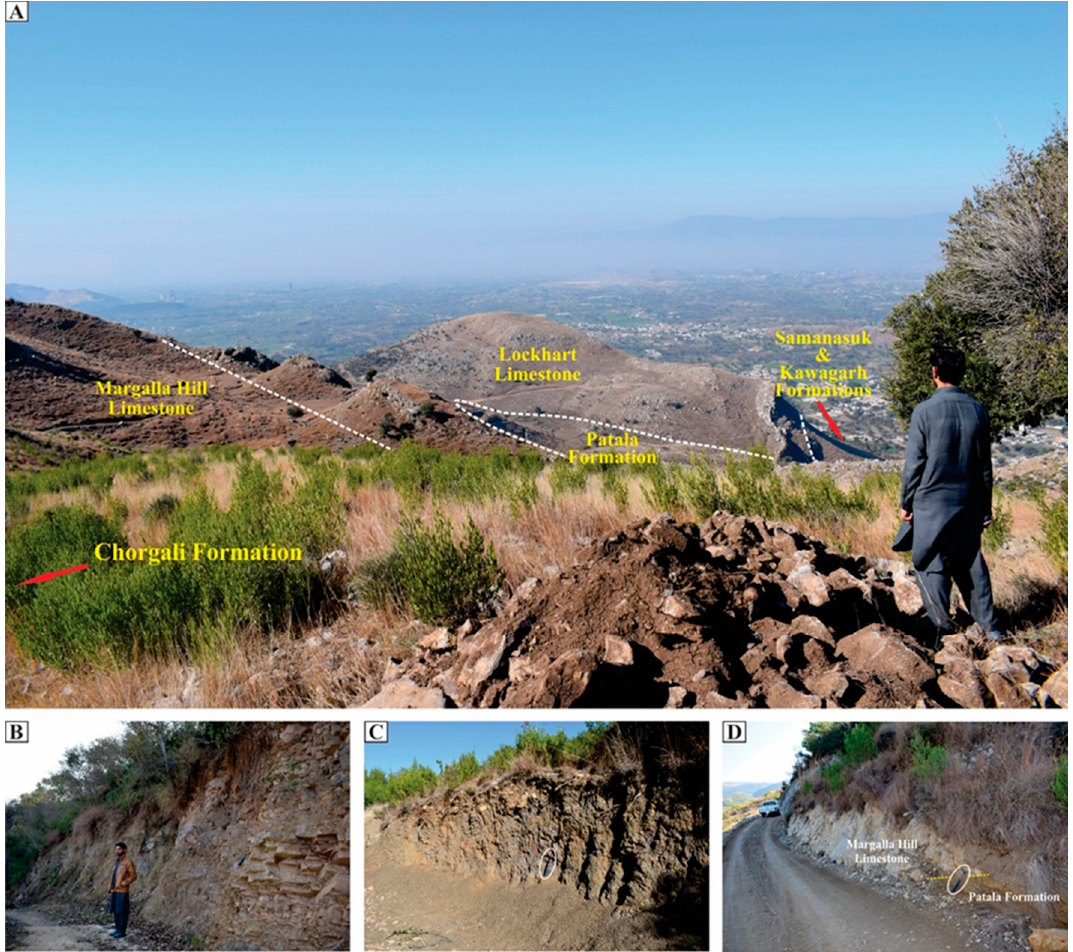
Figure 8. Field photographs at locations indicated in Figure 1. ( A ) Showing different formations exposed in the study area (photo taken at 33.8592 N 72.94397 E and man height = 180 cm for scale). ( B ) Showing the Hazara Slates, i.e., a non-carbonate sequence (33.86615 N 72.9277 E; man height = 180 cm for scale). ( C ) Showing the Patala formation (33.863123 N 72.95020 E; hammer length (white circle) = 32 cm for scale). ( D ) Showing the contact between Patala formation and Margalla Hill limestone (33.860744 N 72.946938 E and hammer length (white circle) = 32 cm for scale).